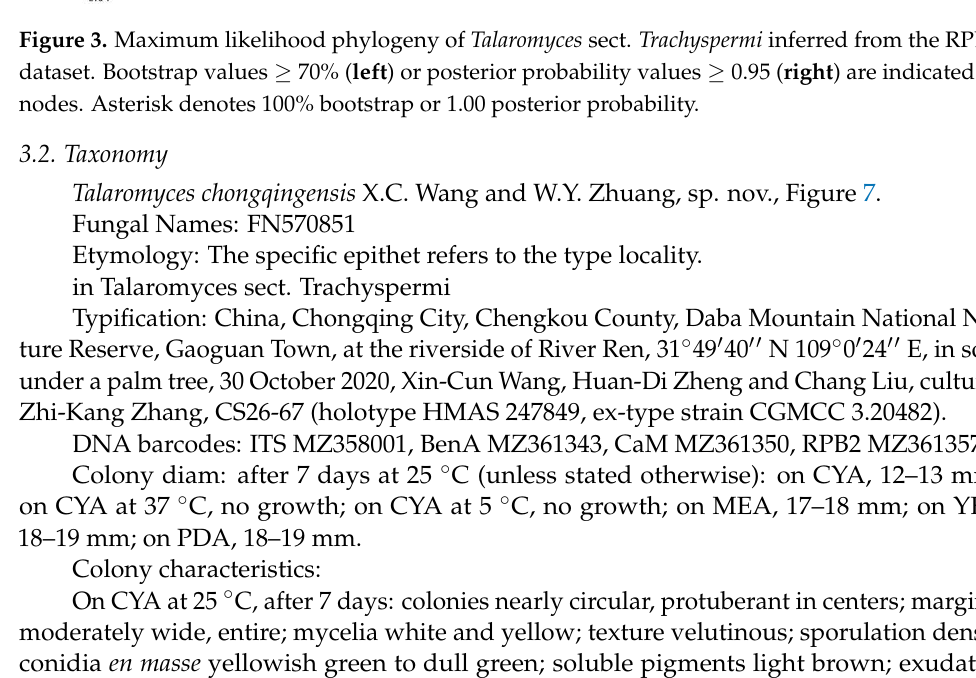
Figure 3. Maximum likelihood phylogeny of Talaromyces sect. Trachyspermi inferred from the RPB2 dataset. Bootstrap values ≥ 70% ( left ) or posterior probability values ≥ 0.95 ( right ) are indicated at nodes. Asterisk denotes 100% bootstrap or 1.00 posterior probability.